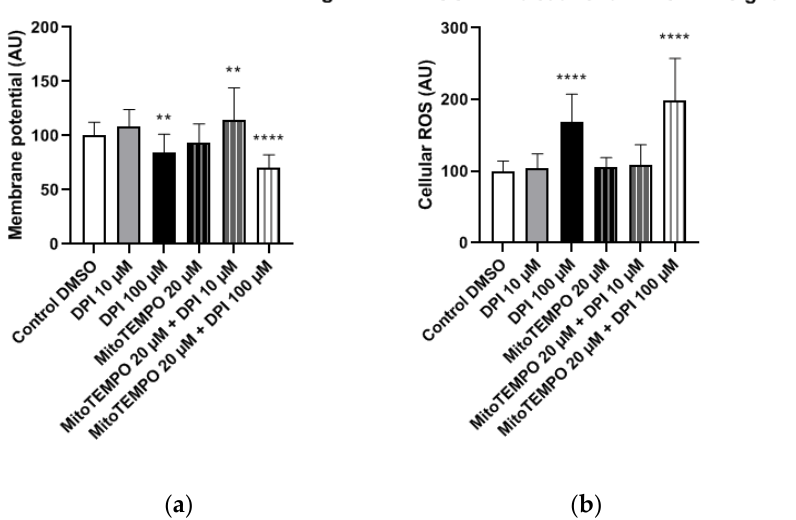
Figure 11. Mitochondrial membrane potential and cellular ROS levels 24 h after the treatment of hAMSCs with diphenyleneiodonium chloride (DPI) and MitoTEMPO. ( a ) Changes in the mitochondrial membrane potential. ( b ) Changes of the cellular ROS levels, an increase caused by a high DPI. Data is represented as means + SD (error bars) ( n = 23; each point was obtained by analyzing 2–4 single cells. ** p < 0.01, and **** p < 0.0001; one-way ANOVA followed by multiple comparison post-hoc Fisher’s LSD test.